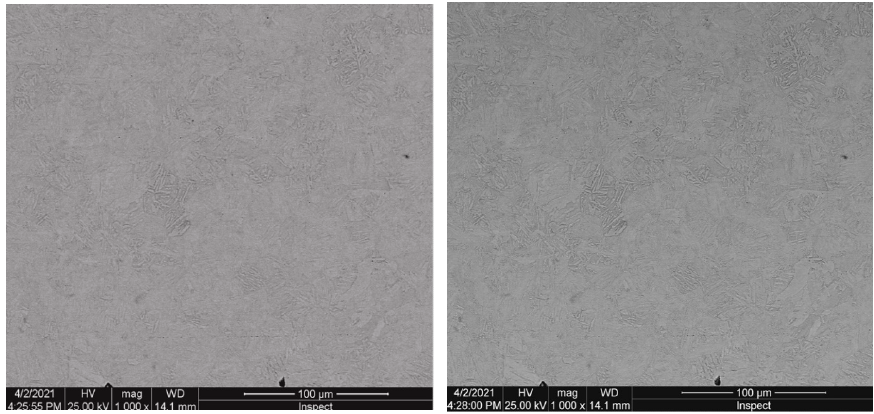
Figure 13. Electronic scanning microscopy for 42CrMo4 sample.